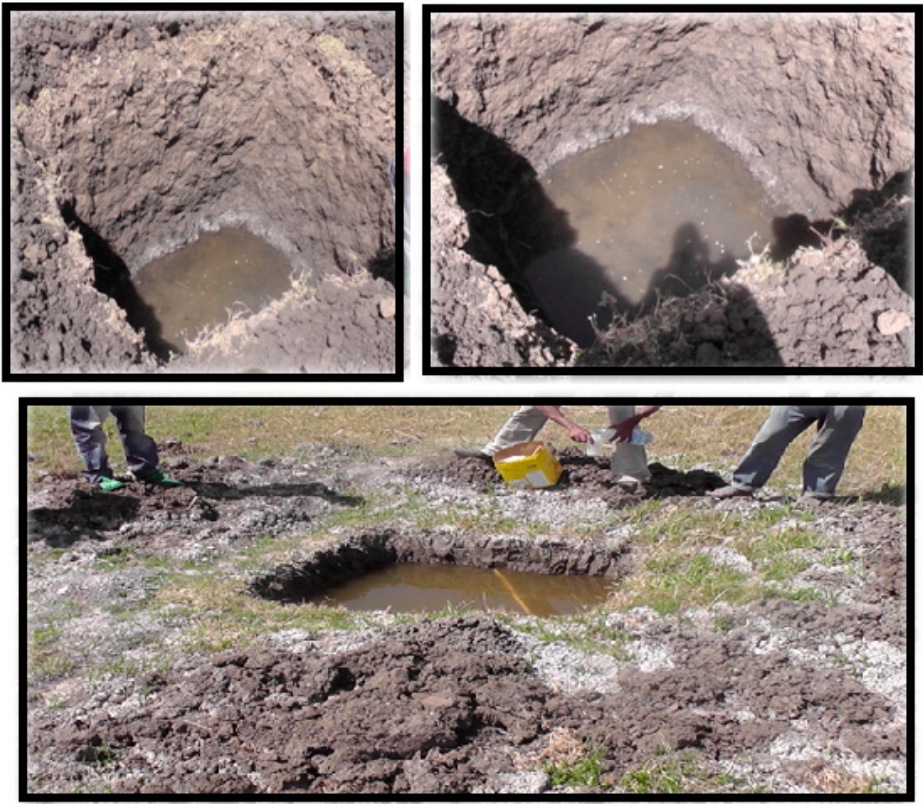
Figure 7. Some of the test pits in the command area.